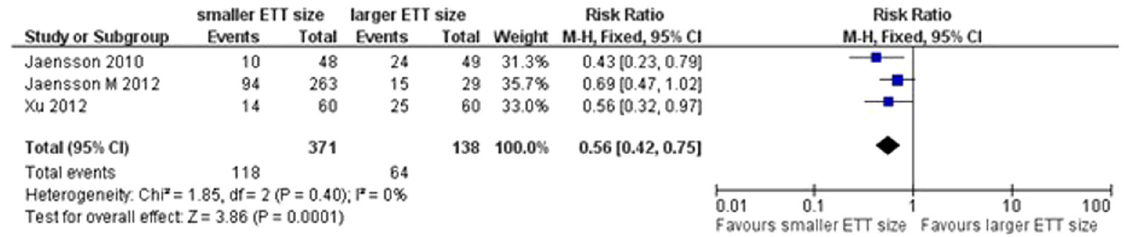
Figure 4. Forest plot of comparison of POST in PACU.